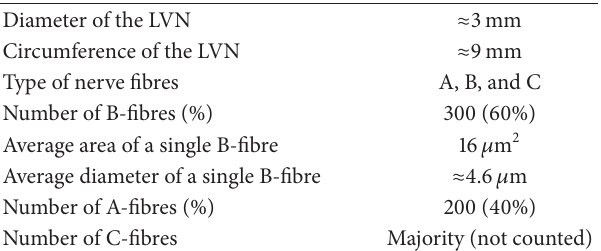
Table 1: Structural topography of the porcine LVN considered in the